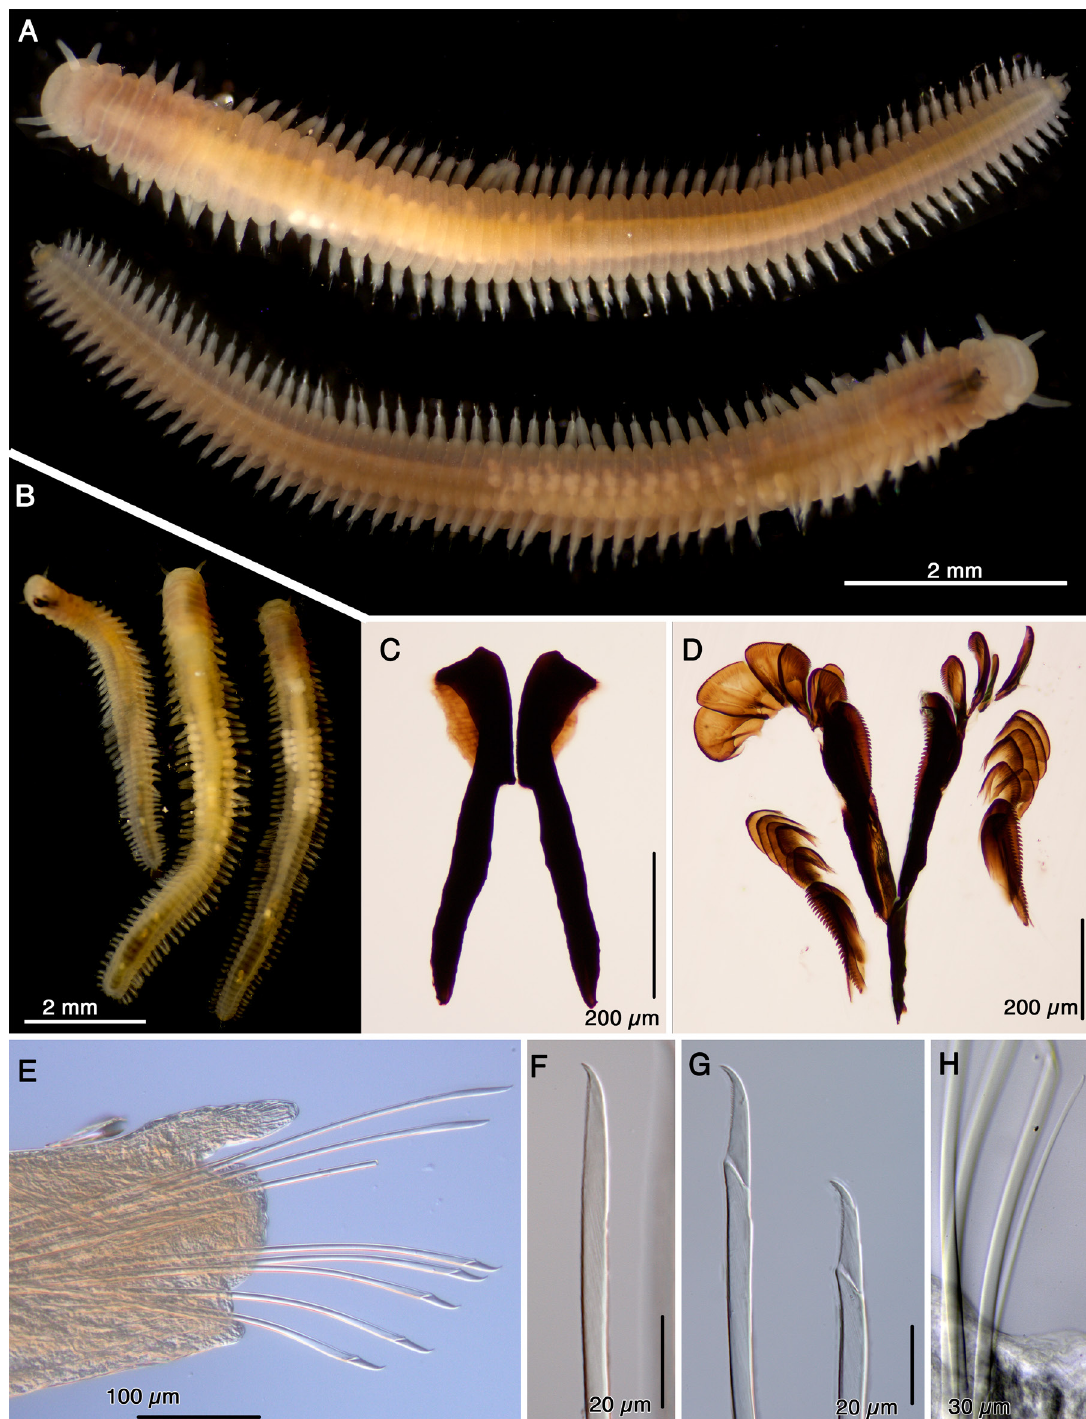
Fig. 7. Ophryotrocha marinae sp. nov. A . Dorsal and ventral views of living paratype (SIO-BIC A14031). B . Whole specimens from paratype (SIO-BIC A14112). C . Mandibles of specimen from paratype (SIO- BIC A6308). D . Maxillae of specimen from paratype (SIO-BIC A6308). E . Parapodium of holotype (SIO-BIC A14109). F . Simple supra-acicular chaetae of holotype (SIO-BIC A14109). G . Compound sub-acicular chaetae of holotype (SIO-BIC A14109). H . Simple sub-acicular chaeta of paratype (SIO- BIC